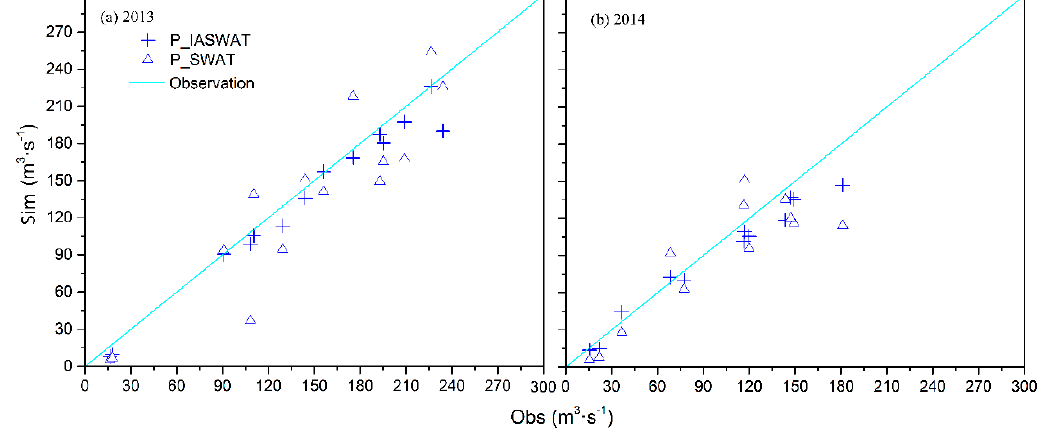
Figure 10. Comparison between the simulated flood peak values and the measured data of all 25 flood events during the model calibration and validation periods.